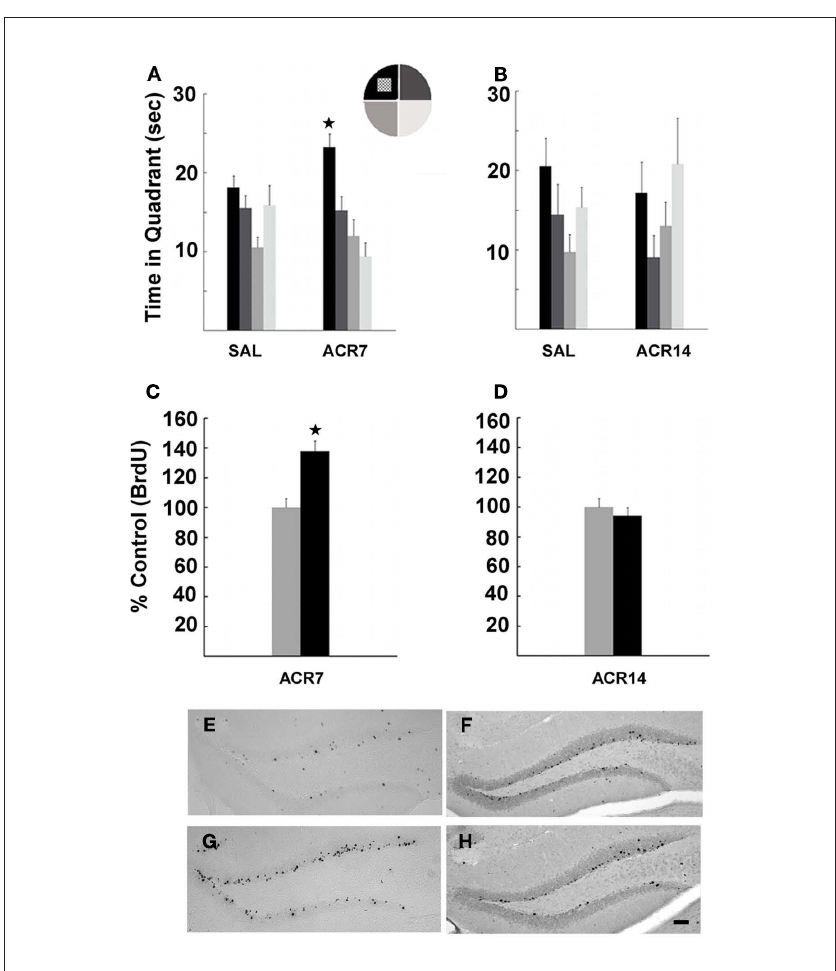
Figure 1 | Water maze performance and neurogenesis in mice treated with saline (SAL) or AiCAr (500 mg/kg) for 7 (ACr7) or 14 days (ACr14). Mice were trained to find the hidden platform in the Morris water maze over 1 week of daily training trials. The ACR7 mice performed better than SAL7 mice in probe trials. (A) Significant retention of platform location in ACR7 mice was observed 4 h (* P < 0.006) after the last training session. (B) ACR14 mice showed